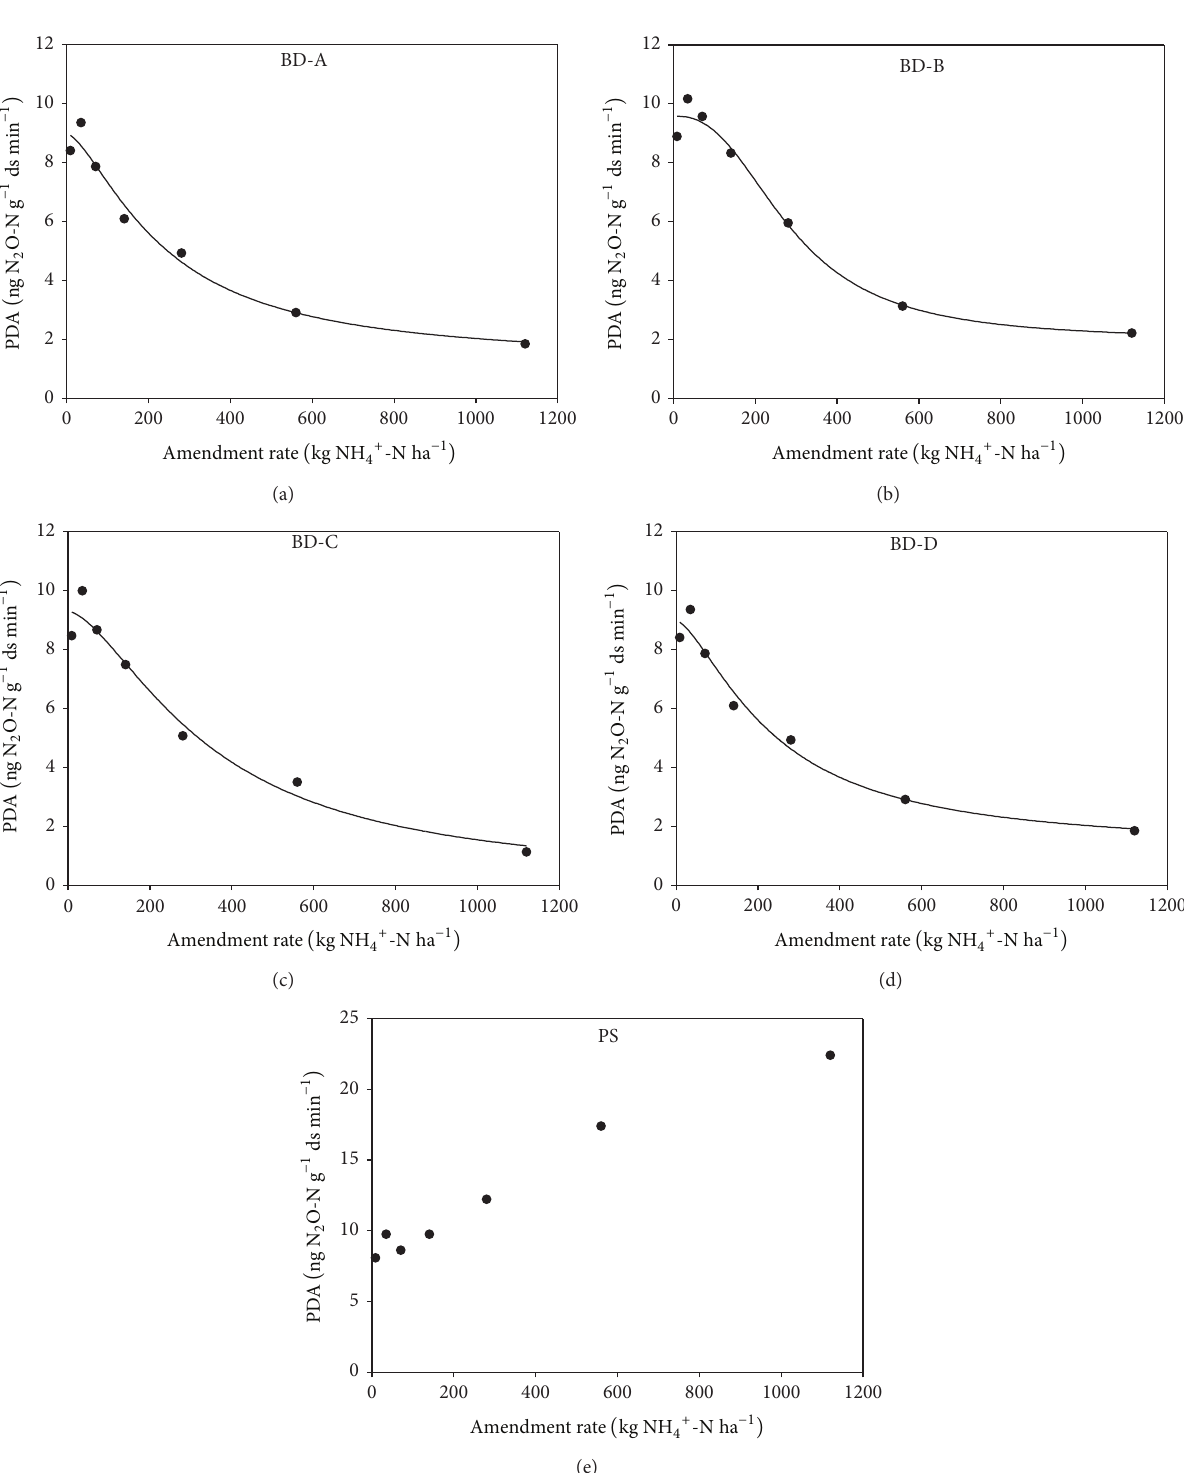
Figure 4: Potential denitrification activity (PDA) in the soil at seven amendment rates of four types of biogas residues (BD-A, BD-B, BD-C, and BD-D) and pig slurry